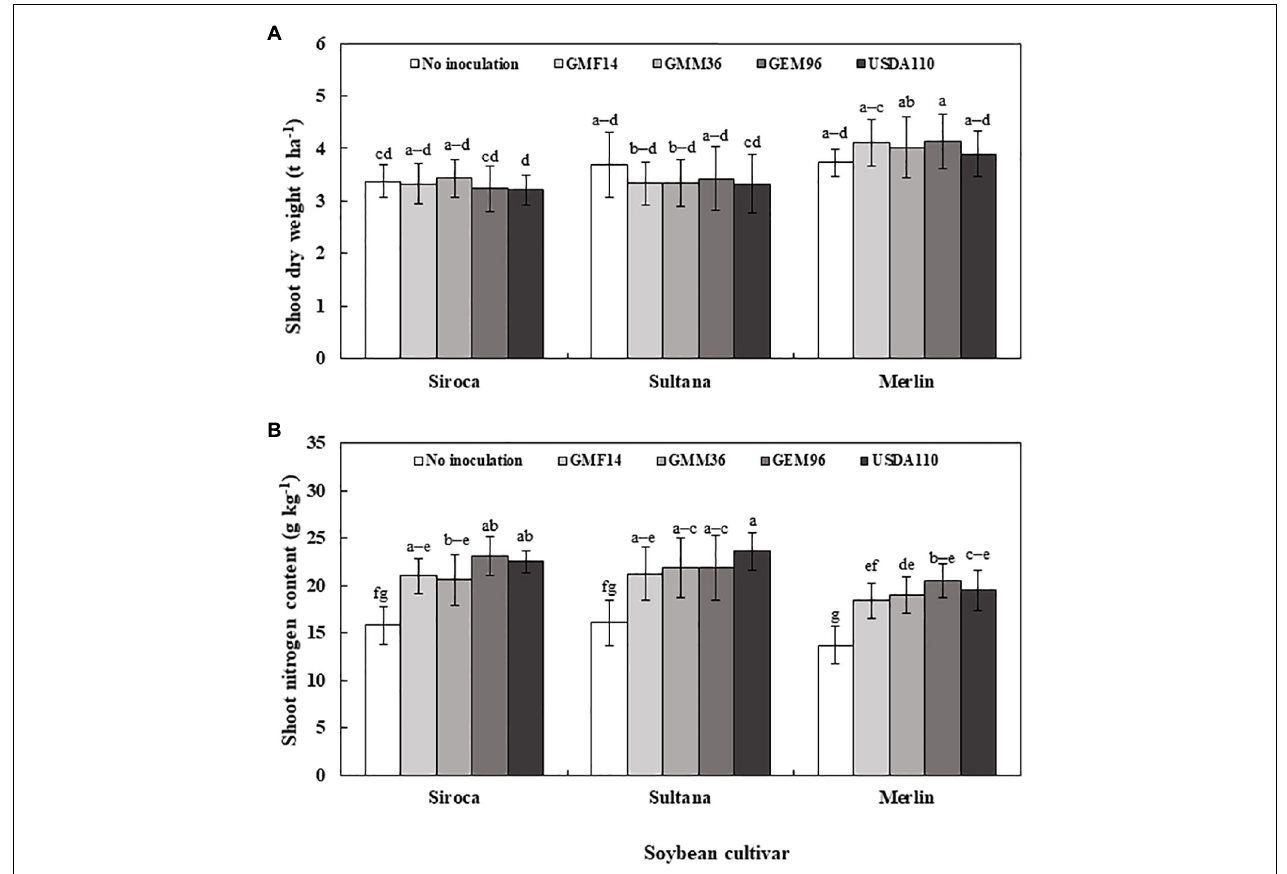
FIGURE 3 | Shoot dry weight (A) and shoot nitrogen content (B) of three soybean cultivars inoculated with different Bradyrhizobium strains in field conditions. The error bars are standard deviation of six replications ( n = 6). Values followed by the same letters on each bar are not significantly different at p ≤ 0.05.